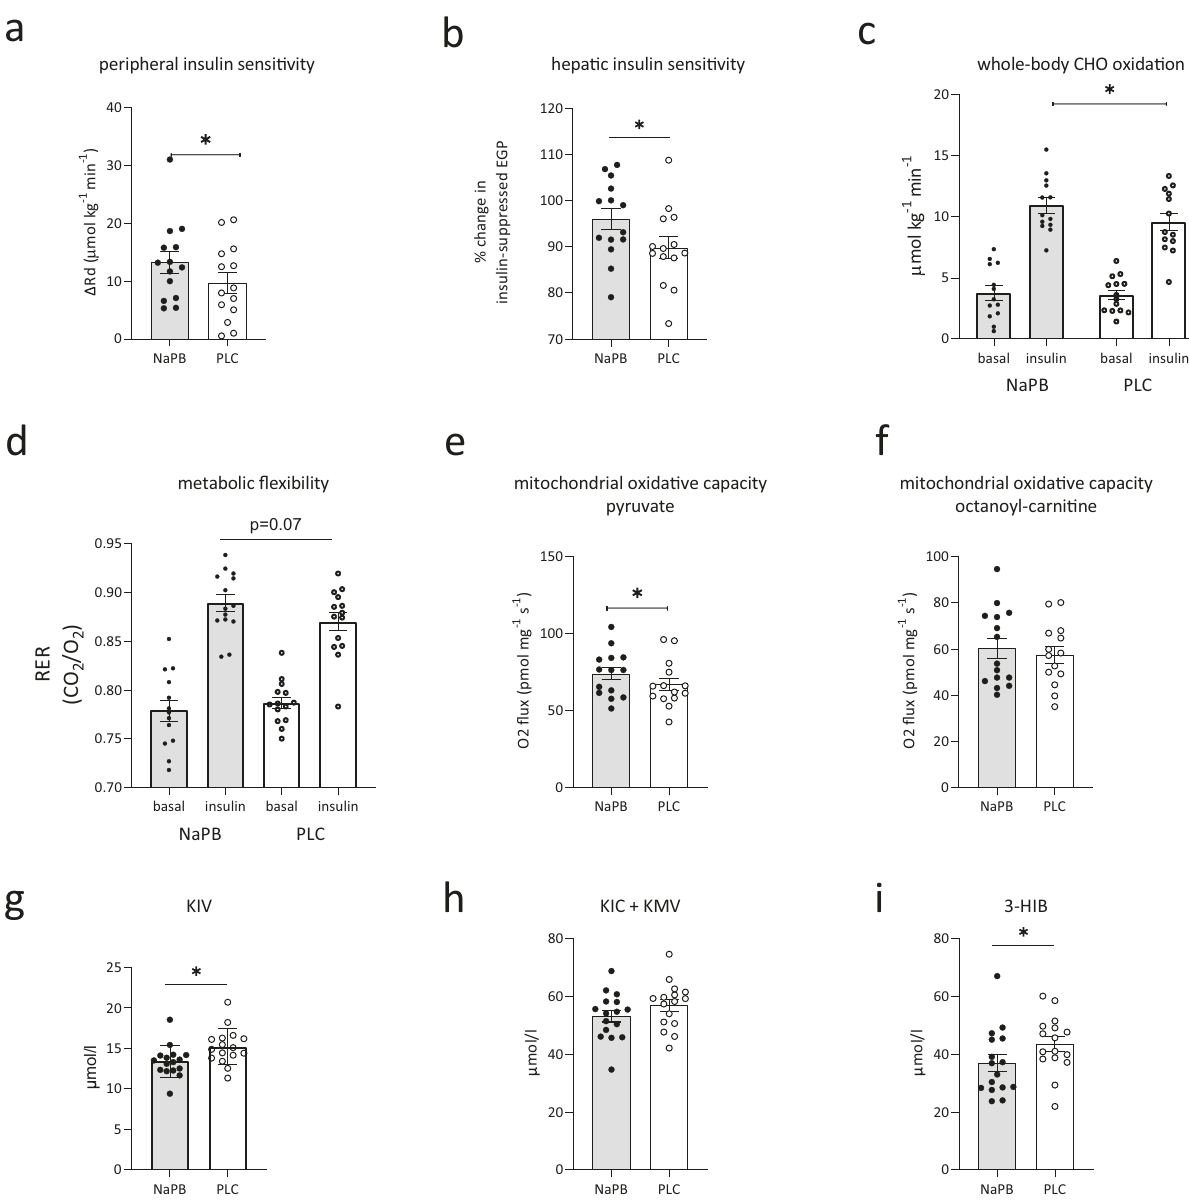
Fig. 3 NaPB treatment effects on metabolic read-out parameters and plasma metabolites. Metabolic parameters measured in patients with T2D after 2-week treatment with NaPB (gray bars, n = 16) and placebo (white bars, n = 16). a peripheral insulin sensitivity expressed as the change in insulin- stimulated Rd ( µ mol kg − 1 min − 1 , p = 0.02), calculated as the difference between Rd under high-insulin infusion and Rd during basal conditions, b hepatic insulin sensitivity expressed as the change in insulin-suppressed EGP (%, p = 0.02) under basal conditions versus high insulin infusion, c